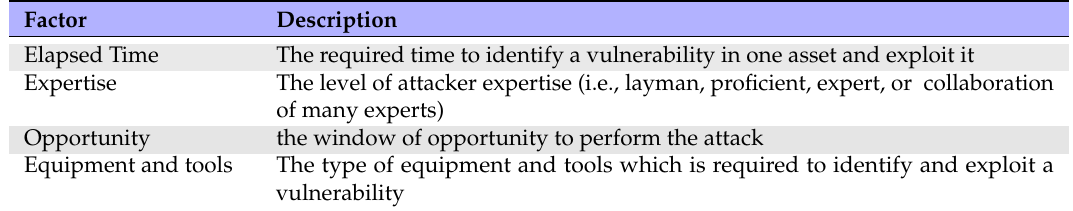
Table 2. Factors for calculating the attack difficulty based on